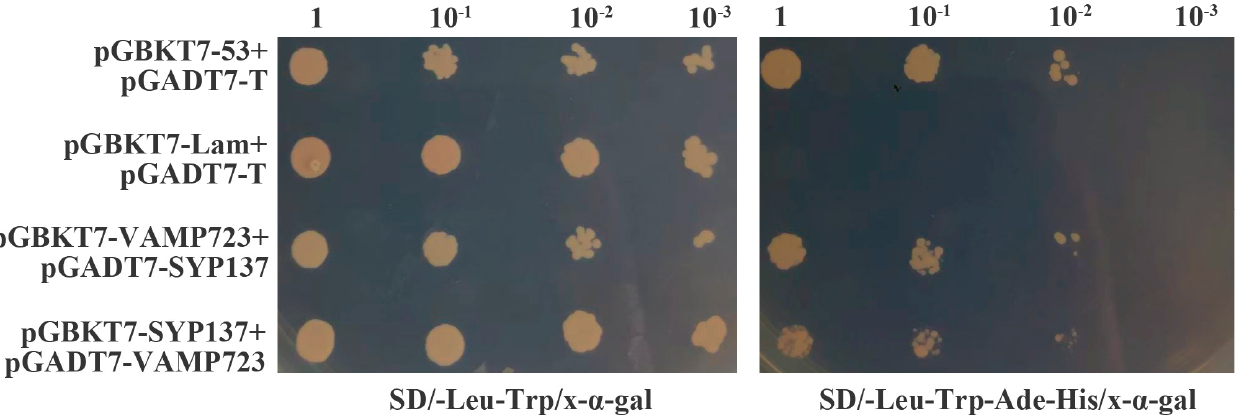
Figure 6. The interaction between TaSYP13 and TaVAMP723 proteins and their potential interactors in a yeast two-hybrid system. The interaction between SV40 large T-antigen (T) and murine p53 (53), T − AD + 53 − BD, was used as the positive control, while the interaction between T-antigen and human lamin C (Lam), T − AD + Lam − BD, was used as the negative control.